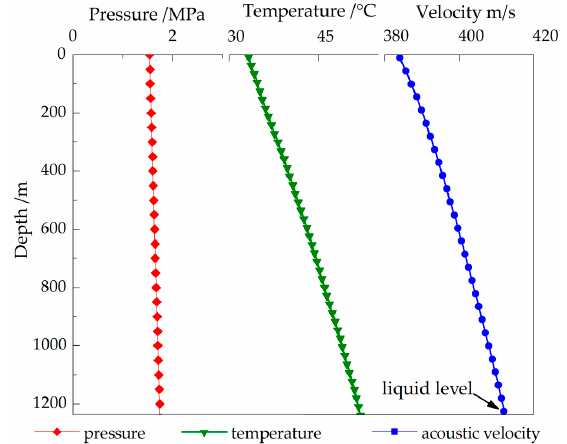
Figure 19. Pressure, temperature and acoustic velocity distribution in annulus.